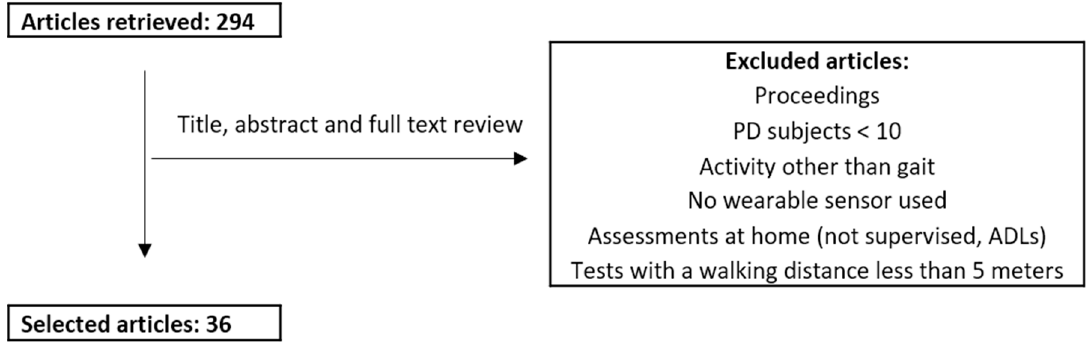
Figure 2. Review process. PD: Parkinson´s disease.